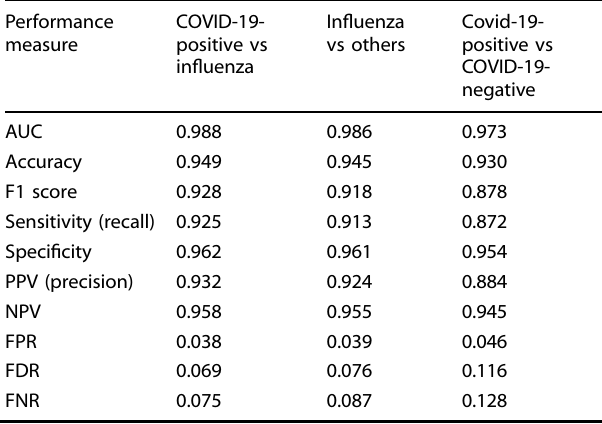
Table 3. Performance metrics of different XGBoost models for predicting the given record as COVID-19-positive or in fl uenza or COVID-19-negative when tested on internal validation or test set.